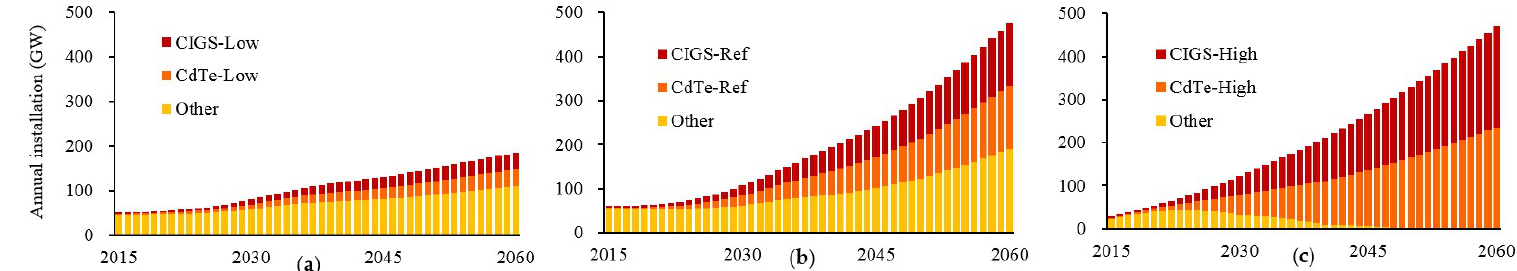
Figure 4. Annual Solar power installation. ( a ) RTS ( b ) 2DS ( c ) B2DS.